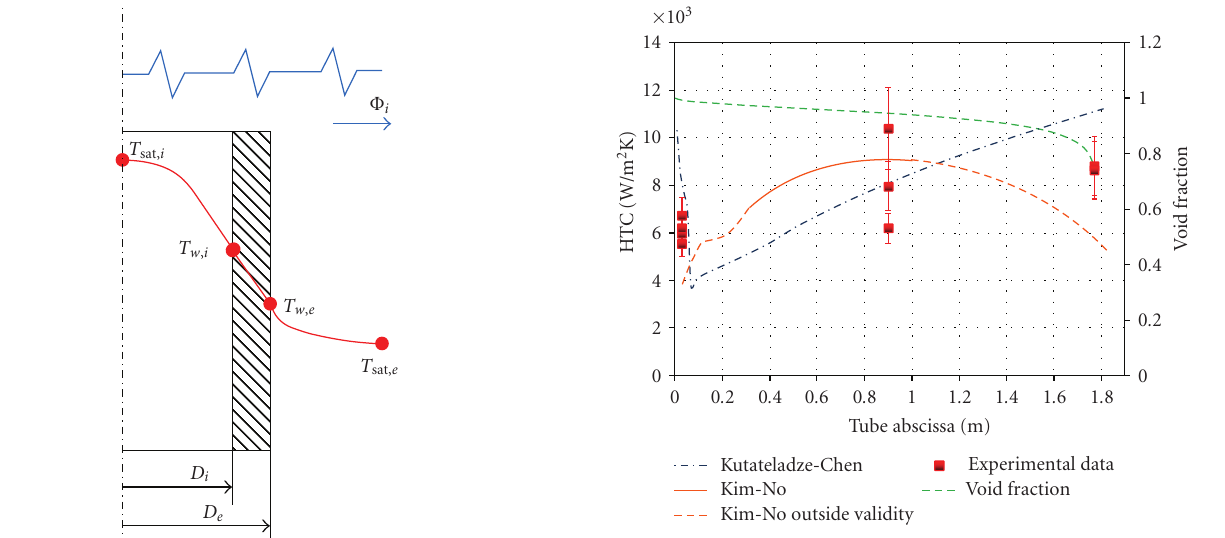
Figure 19: Sketch of heat transfer and temperature distribution in a single tube.